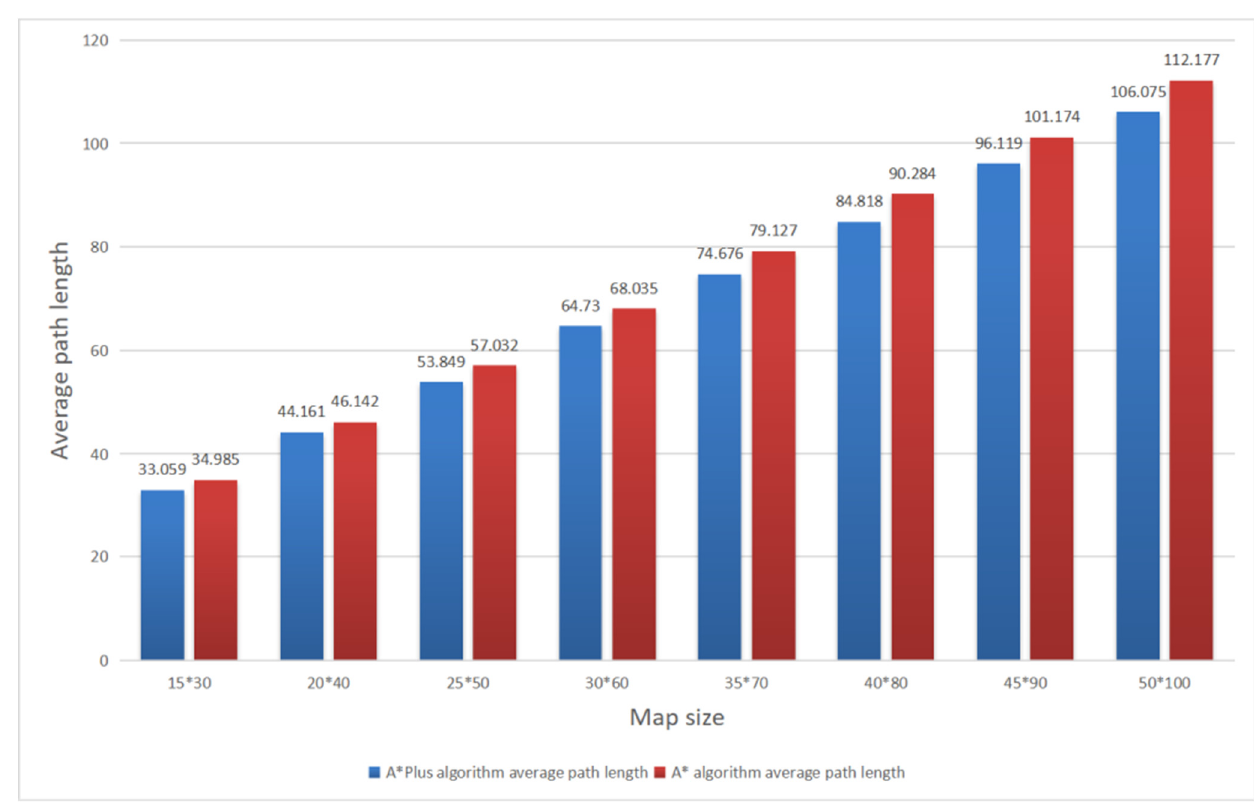
Figure 11. Comparison of moving paths between A-star algorithm and A-star Plus algorithm.